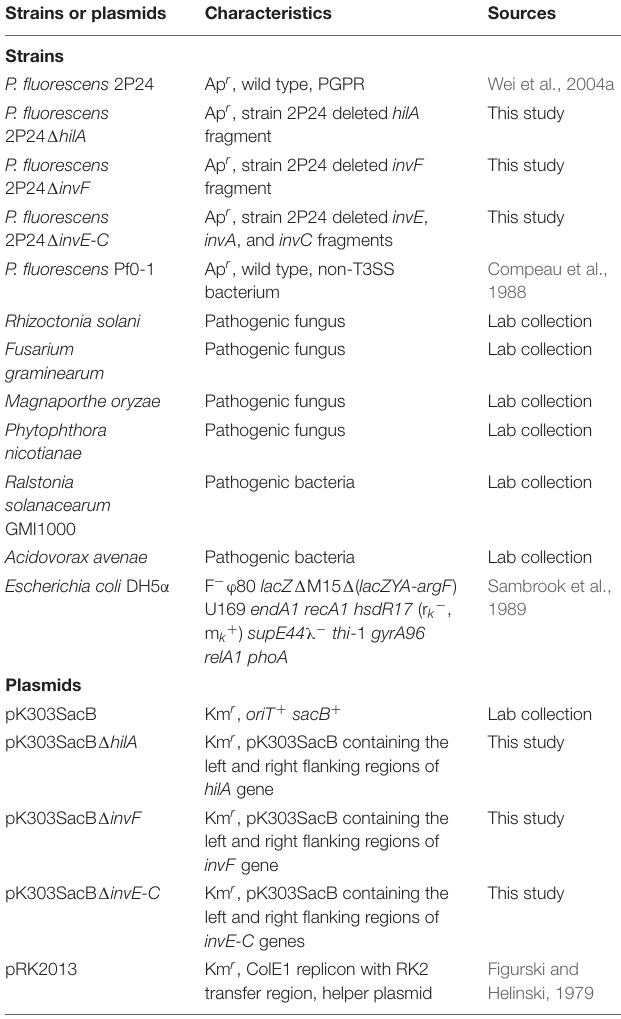
TABLE 1 | Strains and plasmids used in this